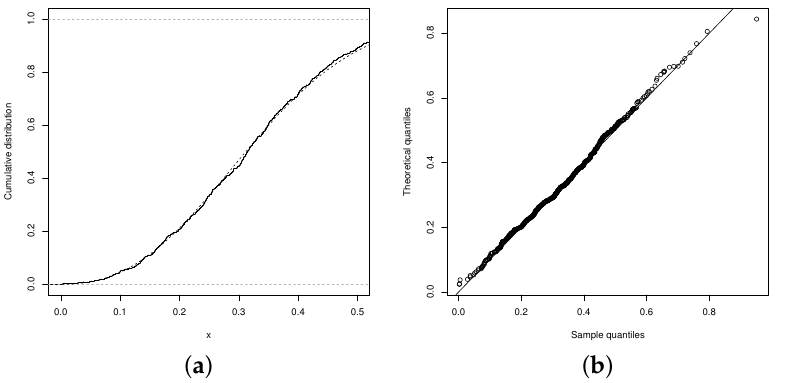
Figure 4. ( a ) Empiric CDF (solid line) and UPSN distribution (dashed line), ( b ) QQplot UPSN distribution.